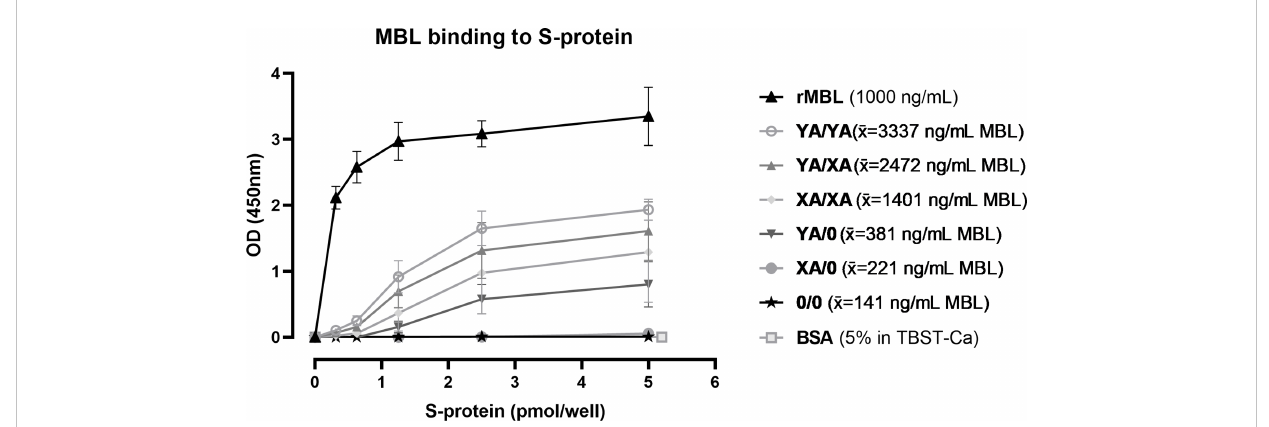
FIGURE 8 Binding of MBL to SARS-CoV-2 spike protein. Recombinant SARS-CoV-2 spike protein was immobilised on a 96-well plate in different concentrations (0-5 pmol/well). Recombinant MBL (rMBL; 1000 ng/mL), BssSA (5% in TBST-Ca 2+ ) or serum from individuals with known MBL2 genotypes (10% in TBST- Ca 2+ ) were incubated on the plates with captured spike protein and bound MBL was detected. Genotypes YA/YA (n=5), YA/XA (n=3), XA/XA (n=3), YA/0 (n=4), XA/0 (n=2) and 0/0 (n=3) were tested, while average MBL levels of the individuals in each group are included in the legend (x ̄ ). Results are presented in mean ± SD. The same results were observed in two independent experiments. OD, optical density; S-protein, SARS-CoV-2 spike protein; rMBL, recombinant MBL; x ̄ , average concentration; BSA, bovine serum albumin; TBST-Ca, Tris-HCl buffer containing